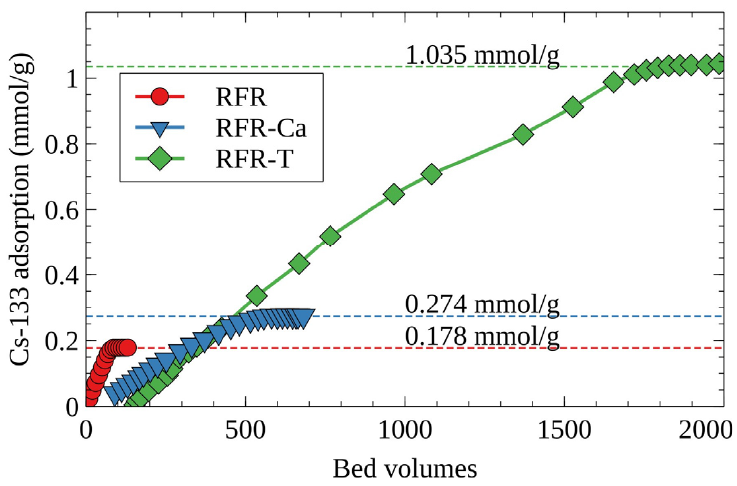
Figure 5. Integral curves of cesium accumulation on RFR under dynamic conditions, model solution No. 1, initial concentration of the stable isotope Cs-133—100 mg/L, grain size—0.1–0.2 mm, solution flow rate—7.5 BV/h.